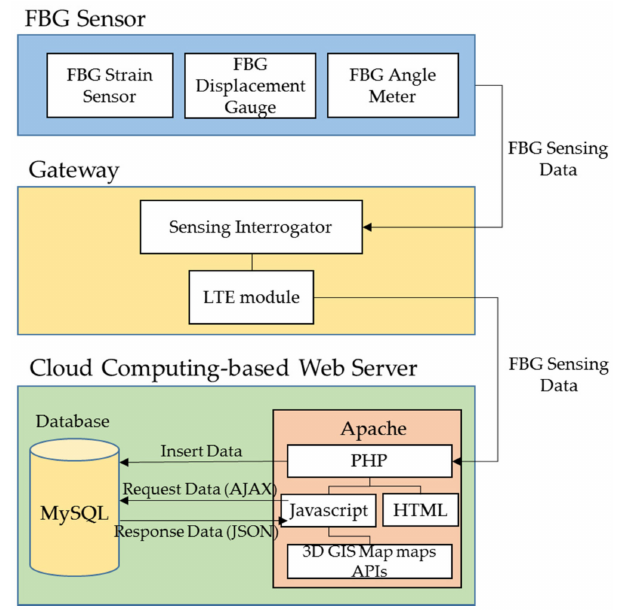
Figure 8. Configuration diagram of the cloud computing-based pier type port structure stability evaluation